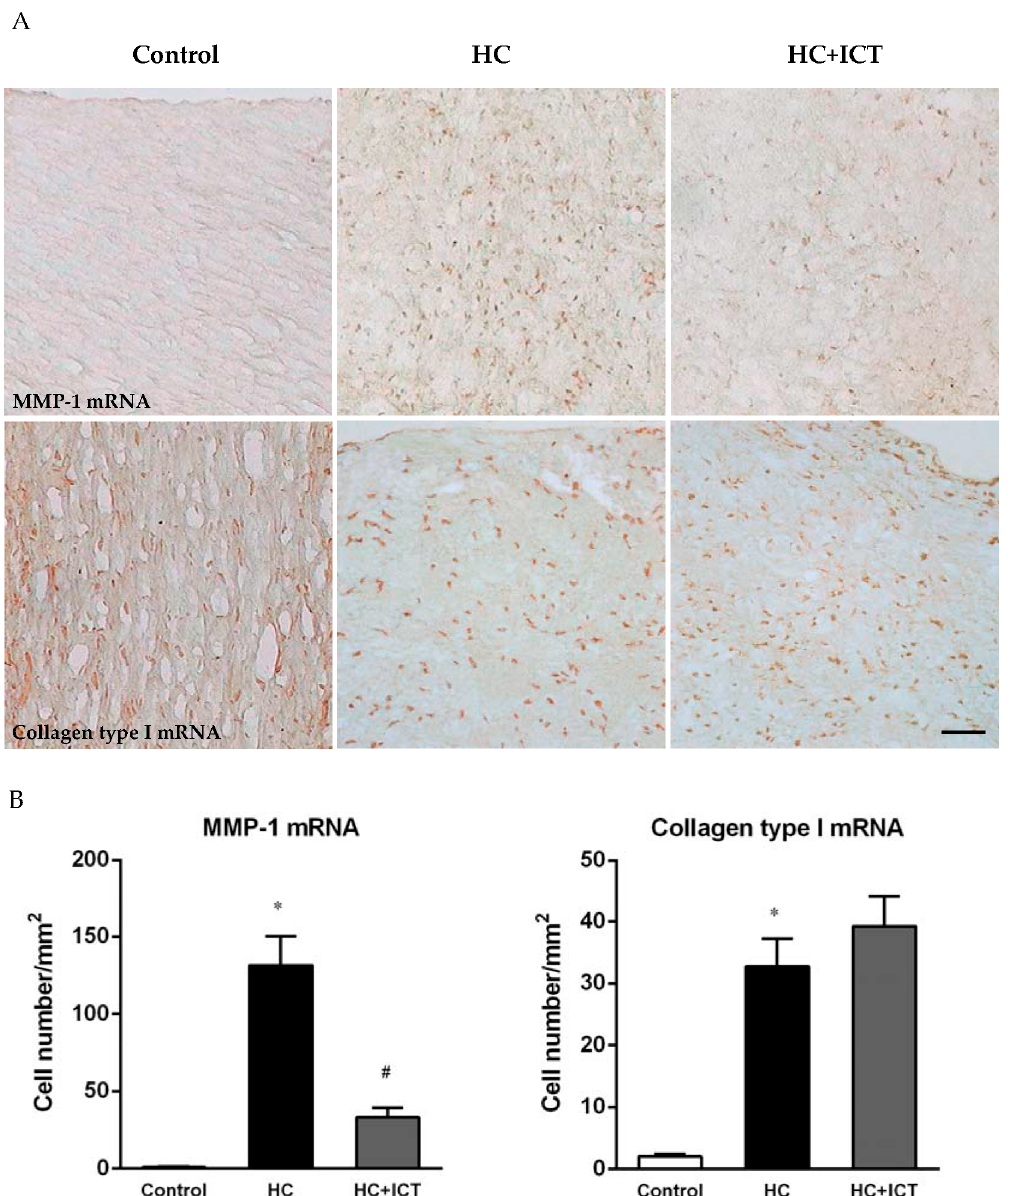
Figure 4. ICT lowered MMP-1 mRNA expression in intima of aorta. ( A ) Representative images of in situ hybridization for MMP-1 and collagen type I mRNA in cross sections of aorta from control, HC, and HC+ICT groups. Scale bar = 50 µm; ( B ) Number of MMP-1 mRNA- and collagen type I mRNA-positive cells per mm 2 intima. * p < 0.05, between control and HC groups; # p < 0.05, between HC and HC+ICT groups. n = 9. Data were means ± SEM.